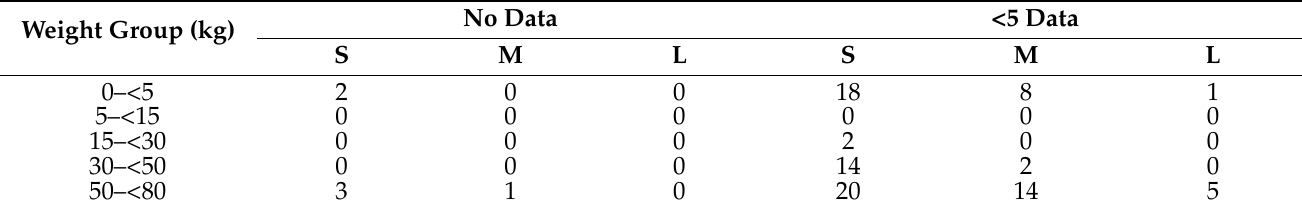
Table 6. Weight groups with a small number of